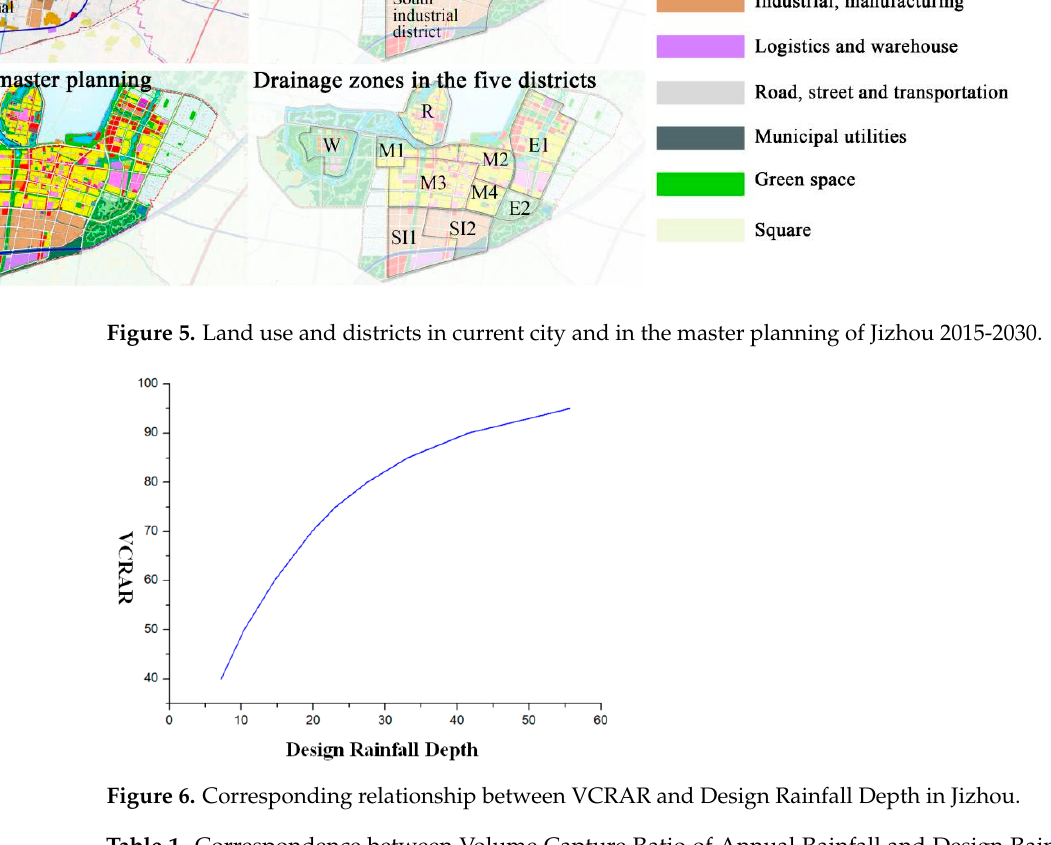
Table 1. Correspondence between Volume Capture Ratio of Annual Rainfall and Design Rainfall